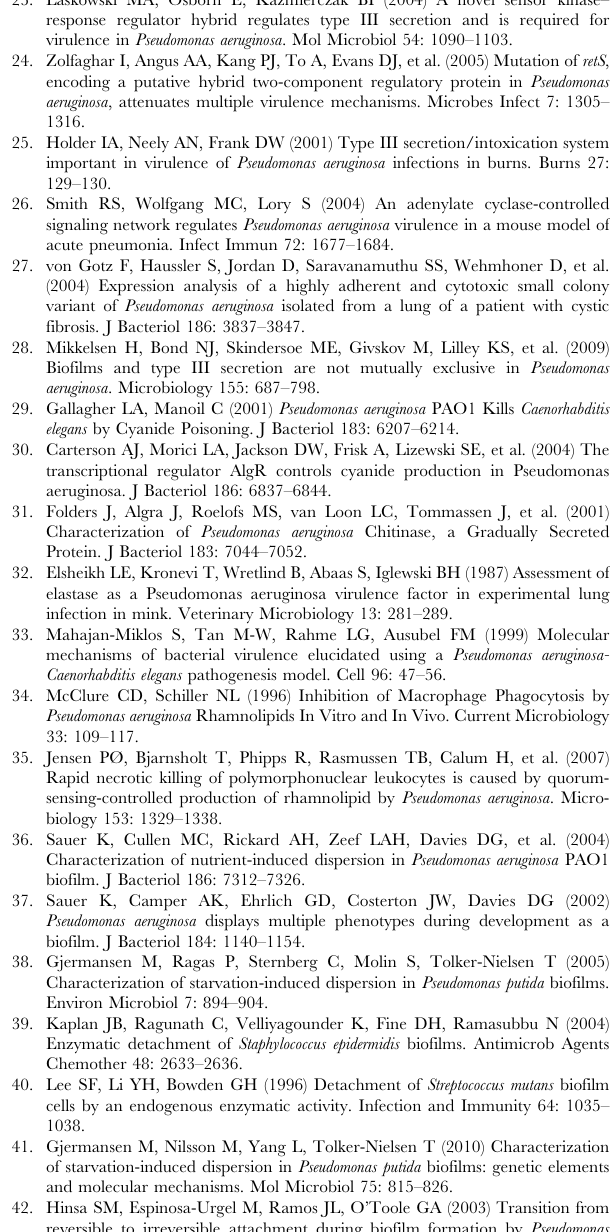
Table S1 qRT-PCR analysis. Transcript levels in P. aeruginosa PAO1 biofilm, D bdlA mutant biofilms, D dipA mutant biofilms and biofilms overexpressing bdlA , as well as dispersed were determined relative to wild-type planktonic cells grown to exponential phase.